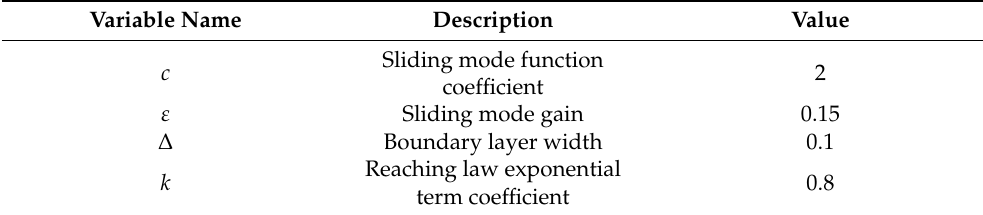
Table 1. Sliding mode controller parameters.